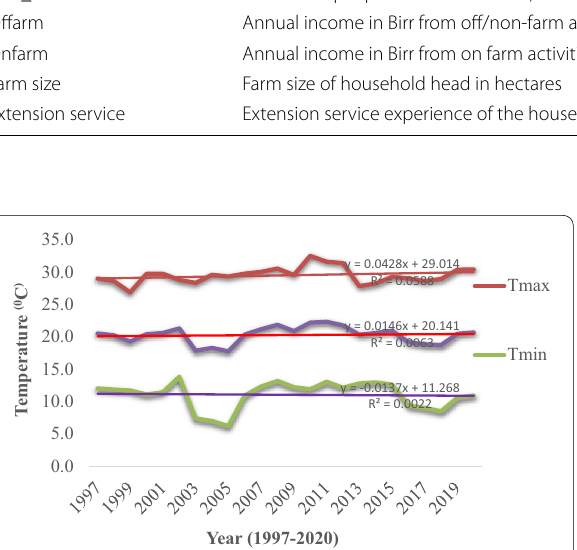
Fig. 3 Trends of maximum, minimum and mean annual temperature from 1997 to 2020